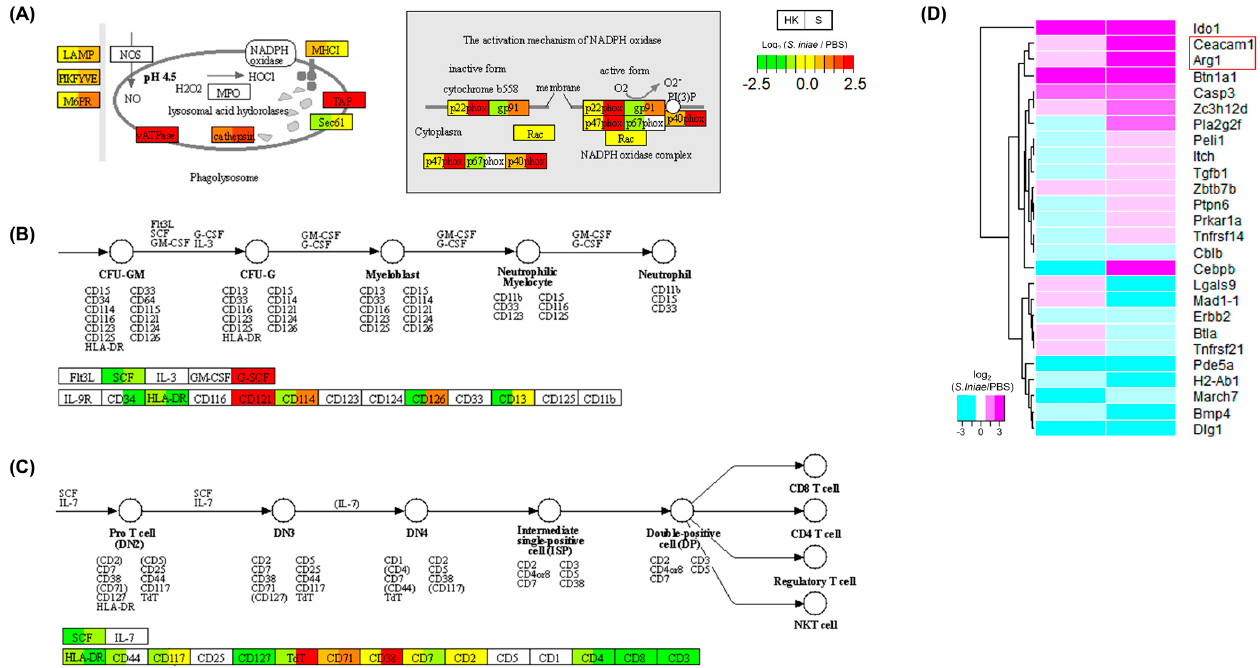
Figure 4. Spleen-specific pathway maps of phagosome and hematopoietic cell lineage in KEGG. Relative gene expression levels in the Streptococcus iniae -infected and phosphate-buffered saline (PBS)-treated groups are shown in these visualizations of ( A ) phagosomes (ko04145), focusing on phagolysosomes and the hematopoietic cell lineage (ko04640) pathway, neutrophils ( B ), and T-cells ( C ). The gene expression levels for the two groups, head kidney (HK) and spleen (S), are shown in each gene box. The higher expression levels of genes are shown in red, and lower expression levels are shown in green. Undetected genes are shown in white. ( D ) Clustering by gene expression profiles related to the negative regulation of T-cells based on the Gene Ontology database. Scores are colored on a log 2 scale ( S. iniae -infected/PBS groups) with magenta as the maximum and cyan as the minimum. Heat maps and clustering were generated using the gplots package in R